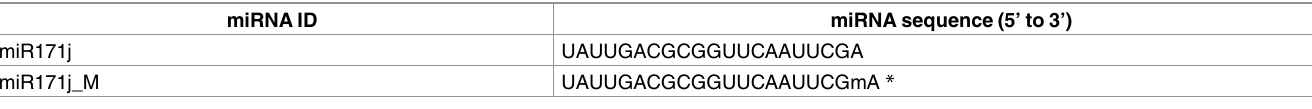
Table 1. Internal control miRNA nucleotide